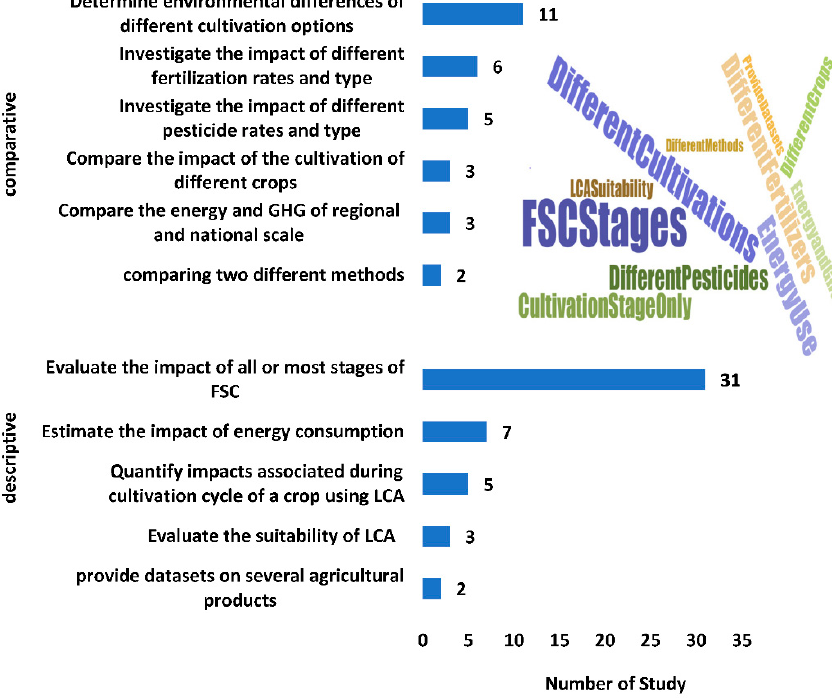
Figure 6. Target audiences in the literature represented as bars (quantitative) and a word cloud (qualitative). Agricultural We divided the products into 11 categories: tomato, fruits, citrus, vegetable, fresh salad, grains, seeds, oil, sugar, flower, and trees, as shown in Figure 7. The most common product was tomato; 13 studies analyzed tomato production, including fresh tomato, canned tomato (whole peeled, paste, and diced), and ketchup. The second most common product was wheat with nine studies. Because some studies involved more than one crop,